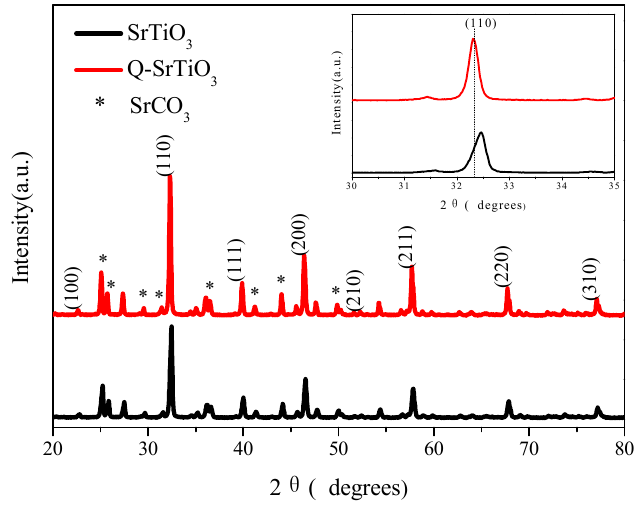
Figure 1. XRD patterns of SrTiO 3 and Q-SrTiO 3 samples.